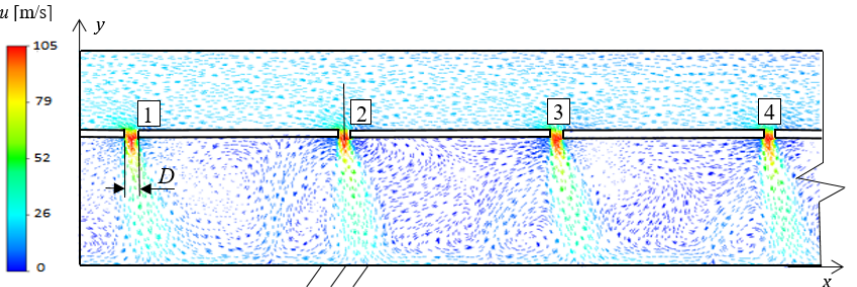
Figure 4. Distribution of velocity vectors in the x-y plane in the area of four cooling nozzles de- picting the generation of fountain effect [11].